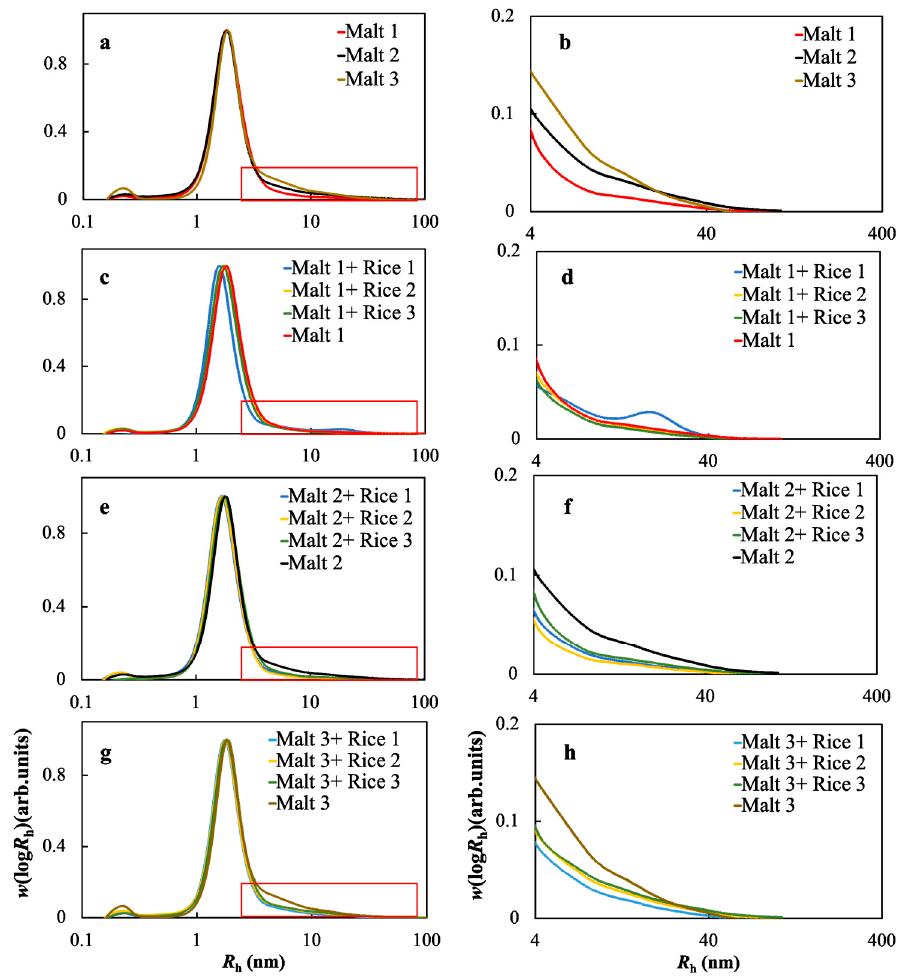
Figure 2. The SEC weight distributions ( w (log R h )) of branched soluble starch polymers (extracted from wort after mashing) as a function of size ( R h ). ( a ) The wort from pure malt samples; ( c , e and g ) different malts with all three different rice adjuncts; and ( b , d , f and h ) are the enlarged figures of the parts in the red boxes in ( a , c , e and g ), respectively. All peaks have been normalised to the highest peak of the figure. SEC parameters are shown in Table S1. All data are based on duplicate measurements.